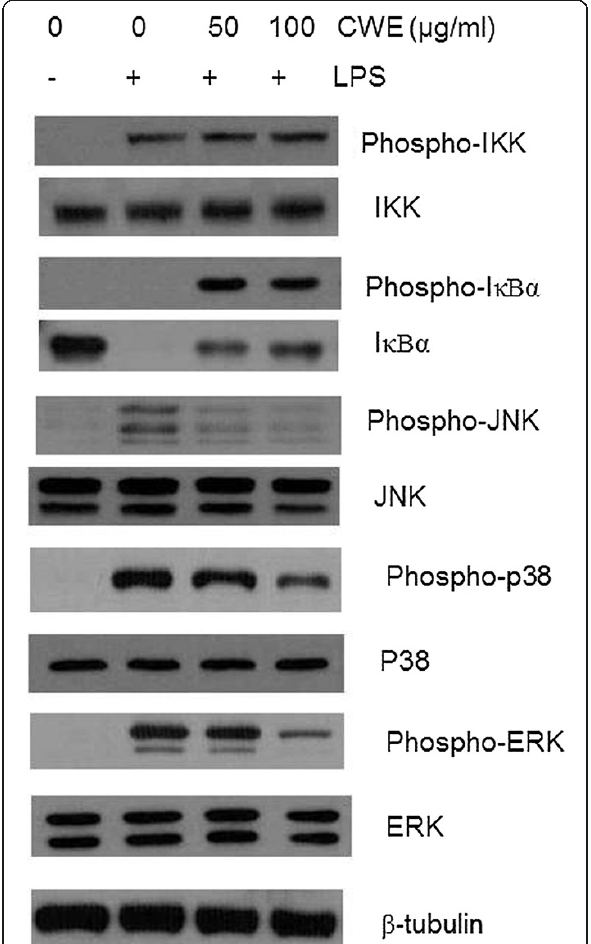
Figure 4 In vitro effect of CWE on LPS-induced I κ B α degradation and MAP kinase activation. Peritoneal macrophages were pretreated with the indicated concentration of CWE for 1 h and then stimulated with LPS for 15 min. Phospho-IKK, I κ B α , phospho-I κ B α ,phospho-JNK, JNK, phospho-p38, p38, phospho-ERK1/2, and ERK1/2 in whole protein extracts were examined by Western blot analysis. Tubulin was used as an internal control. One of the five experiments is